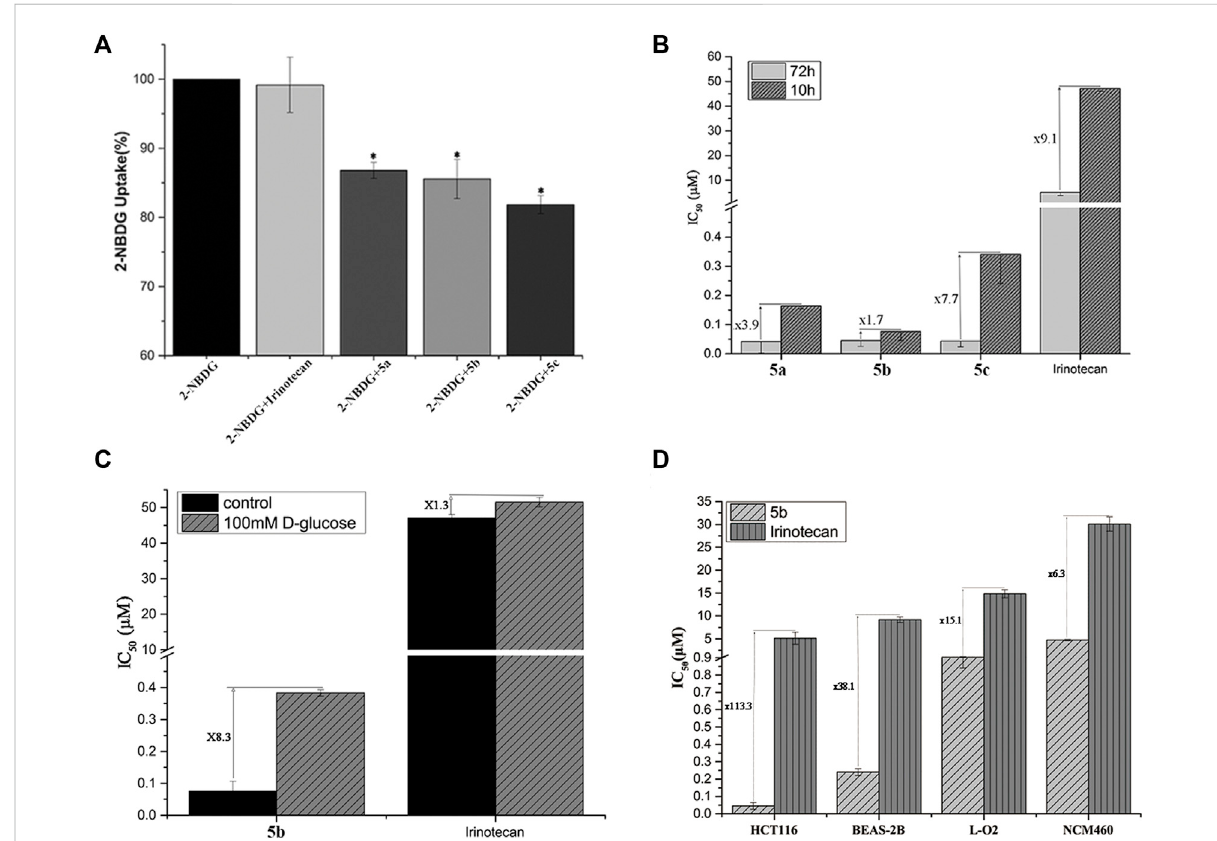
FIGURE 1 (A) Uptake of Glu-SN38 via glucose transporters using fl uorescent probe 2-NBDG as competitor in HCT116 cells. (B) Effect of incubation time on IC 50 values. (C) Effect of D-glucose on IC 50 values. (D) Changes in IC 50 values of 5b and irinotecan in cancer and normal